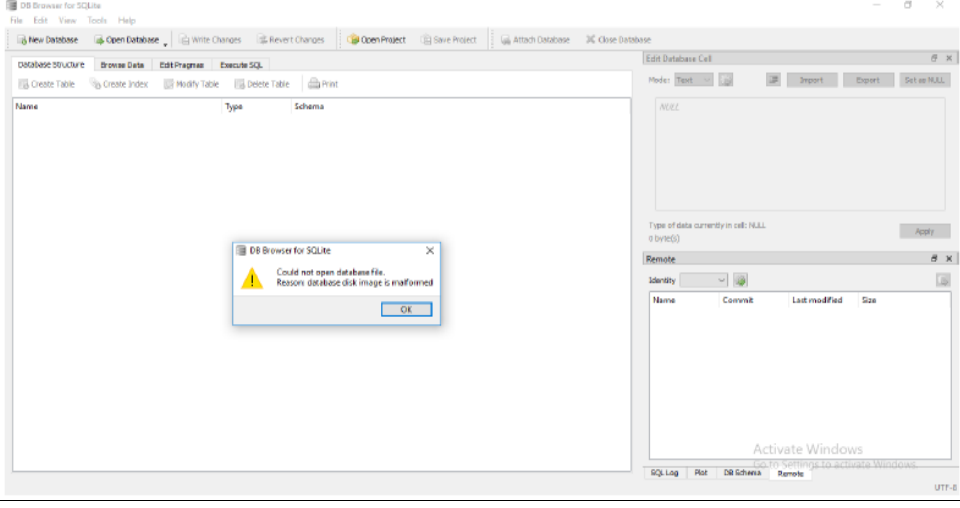
Figure 8. Damaged database: Disk image is malformed